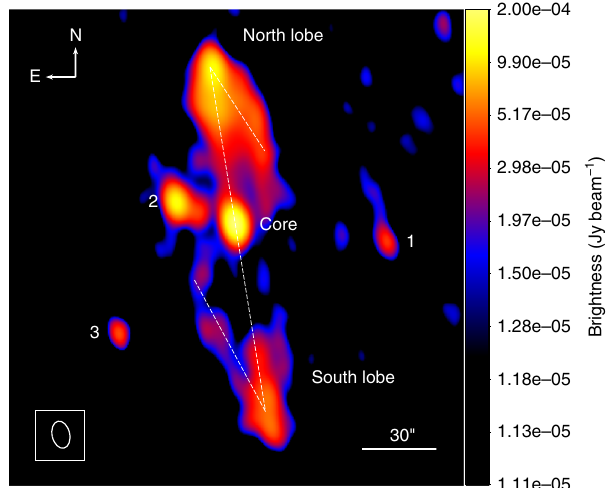
Fig. 1 Z- shaped radio morphology of the microquasar GRS 1758-258. This map was obtained from the concatenation of VLA runs carried out at the 6cm wavelength in the D and C array con fi gurations conducted in 1992, 1993, 1997 (archival data) and 2016 (new data from this work). Details are given in the Methods section and Table 1. The central core and the north and south radio lobes are labelled together with the unrelated sources #1, #2 and #3 in the same fi eld of view. The white dashed line outlines the Z- shaped appearance of the faint emission extensions emanating from both lobes. The bottom left ellipse shows the angular resolution and corresponds to the full width at half maximum of the VLA synthesised beam (11.31×7.18 arcsec 2 , with a position angle of 13°). The right horizontal bar (30 arcsec long) provides the map angular scale, with north being up and east being left. The brightness levels are illustrated by the colour bar to the right. The intensity scale used is Meaningful radio emission starts at the 4 σ level of approximately 15 μ